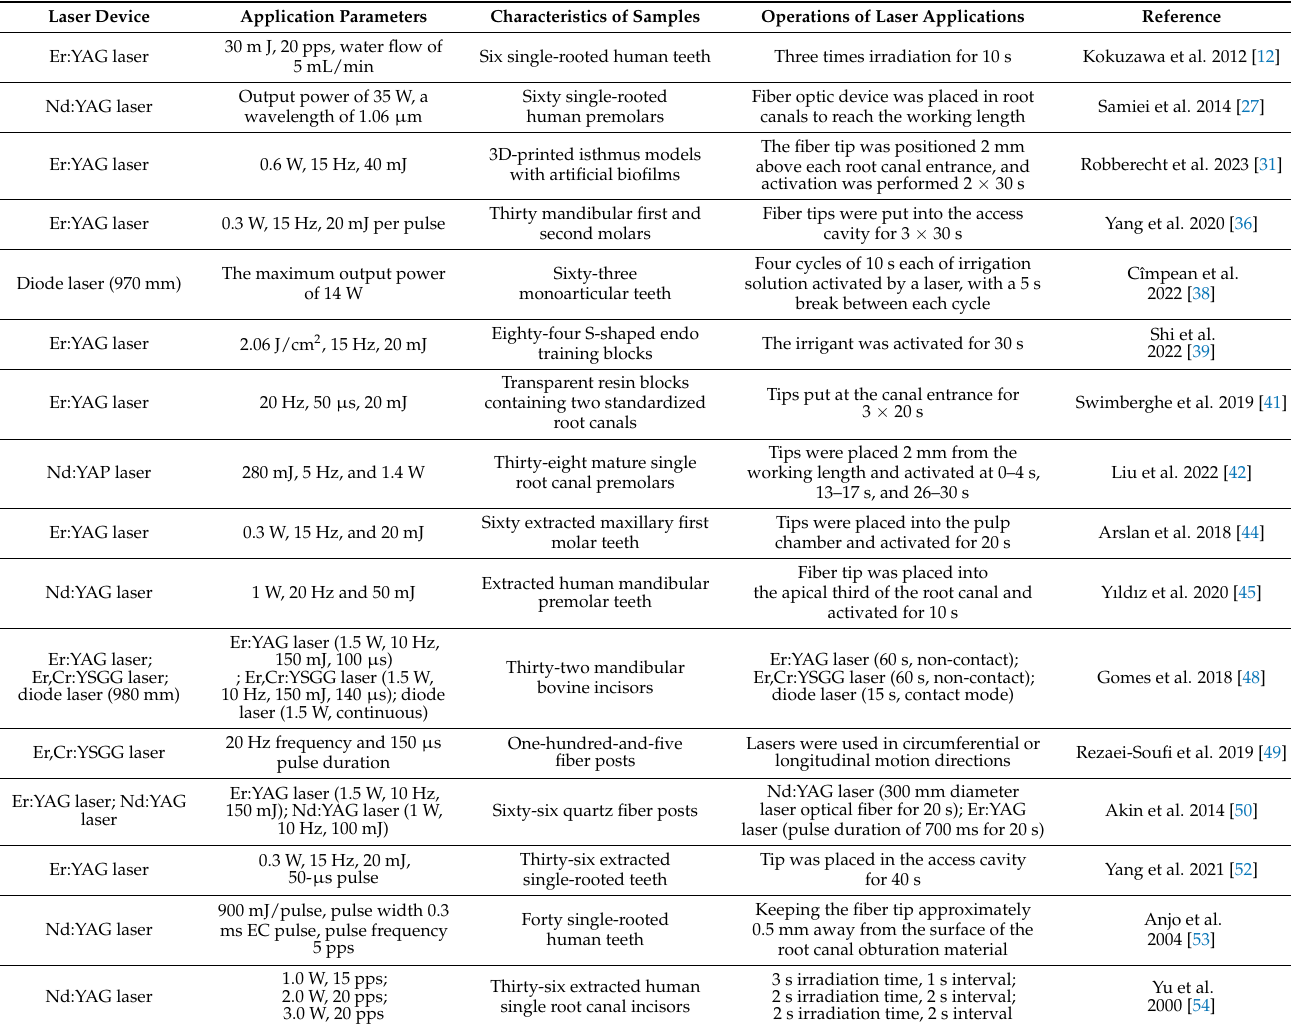
Table 2. In vitro experiments on the application of lasers in root canal